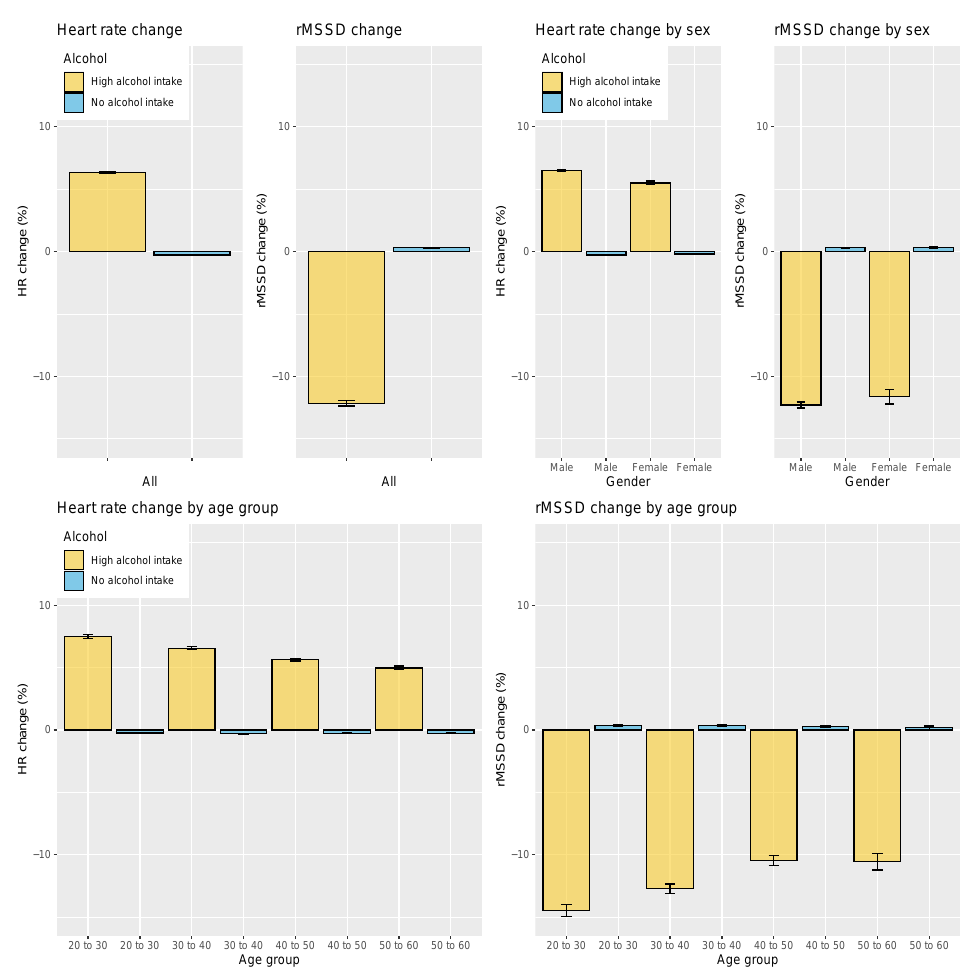
Figure 12. Relation between HR, HRV, and alcohol intake on the entire dataset and grouped by sex or age group. HR is consistently increased on days following higher alcohol intake, while rMSSD is consistently decreased. Error bars indicate the standard error. For sickness, overall, across all age groups and participants, heart rate increased by 6% with respect to when not sick ( p < 0.05, d = 0.97, effect size = large), while rMSSD reduced by 10% when sick with respect to the baseline category of not sick ( p < 0.05, d = 0.47, effect size = moderate; see Figure